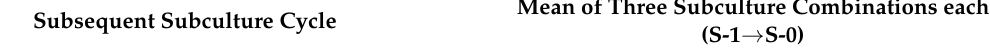
Table 2. The effect of subsequent subculture cycle of S-1 → and S-0 combinations on survival and regeneration of cryopreserved (LN) P. yatabeanus shoot